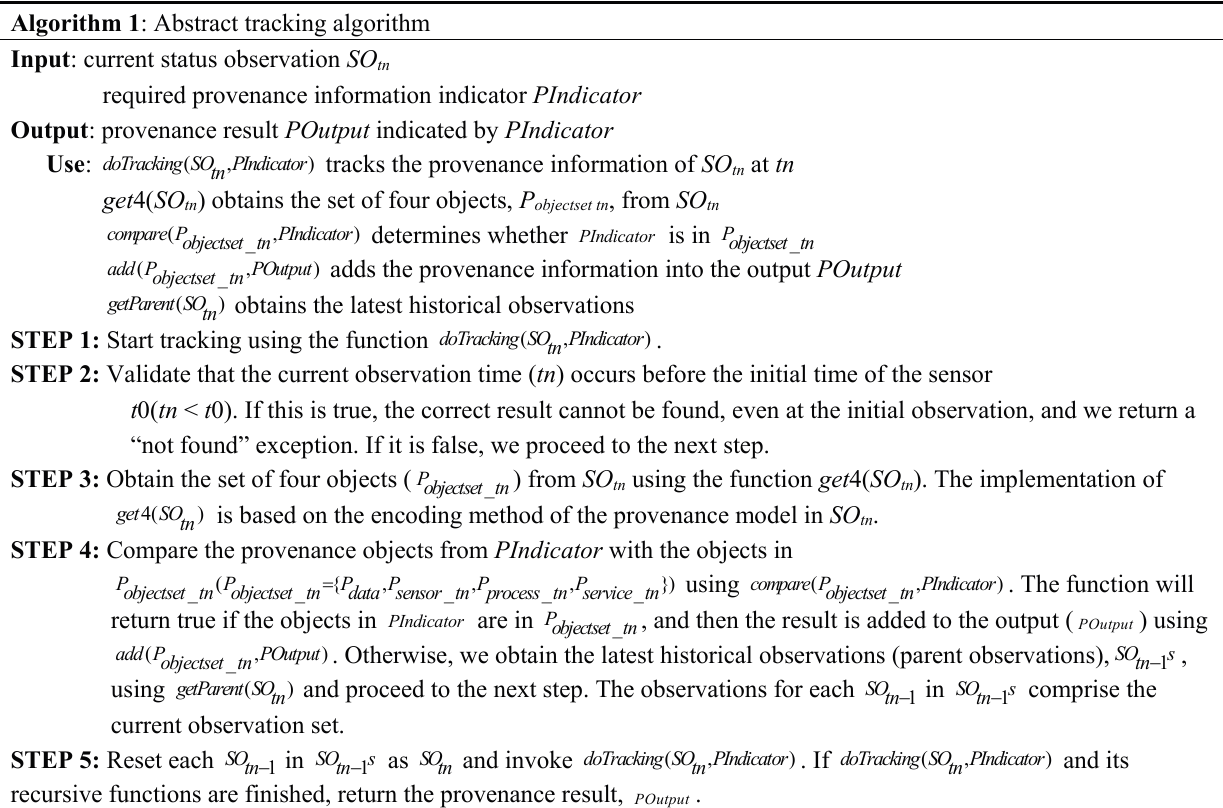
Algorithm 1 : Abstract tracking algorithm Input : current status observation SO tn